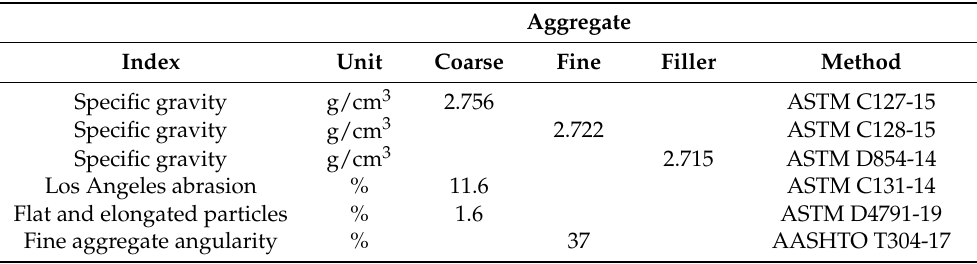
Table 3. Technical index test results of aggregates.